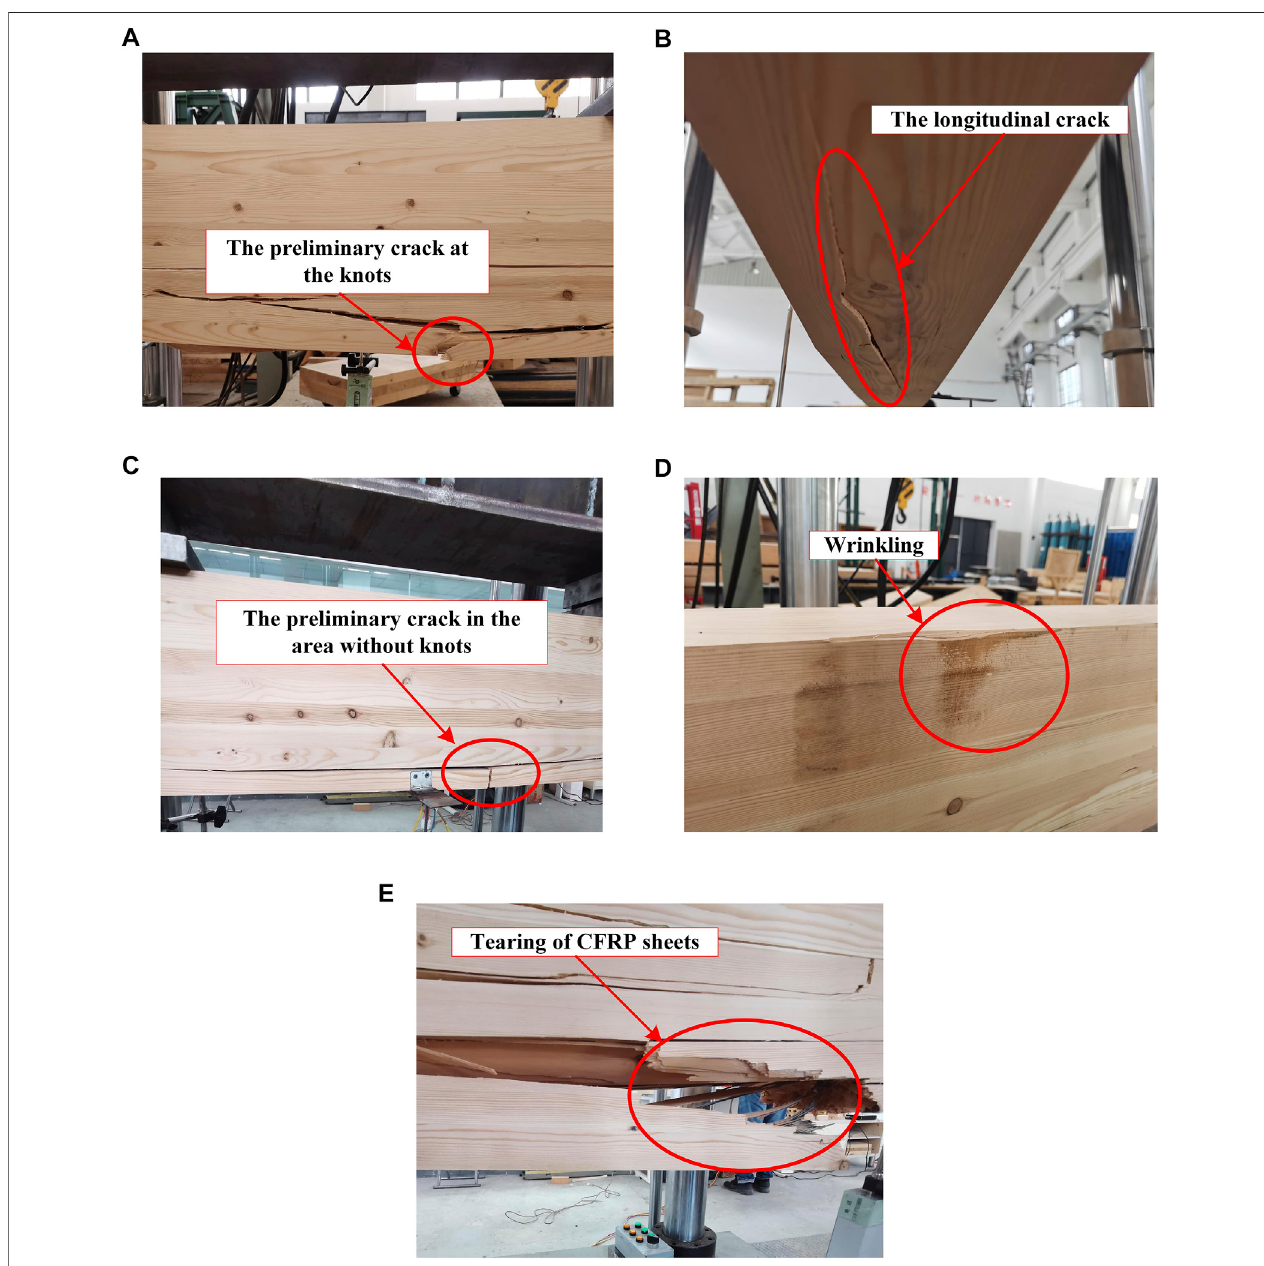
FIGURE4| Bendingfailureofreinforcedbeams: (A) crackatknots; (B) longitudinalcrack; (C) crackintheareawithoutknots; (D) wrinklingonthecompressiveside of beam in group WH+H; and (E) tearing of the CFRP sheets.